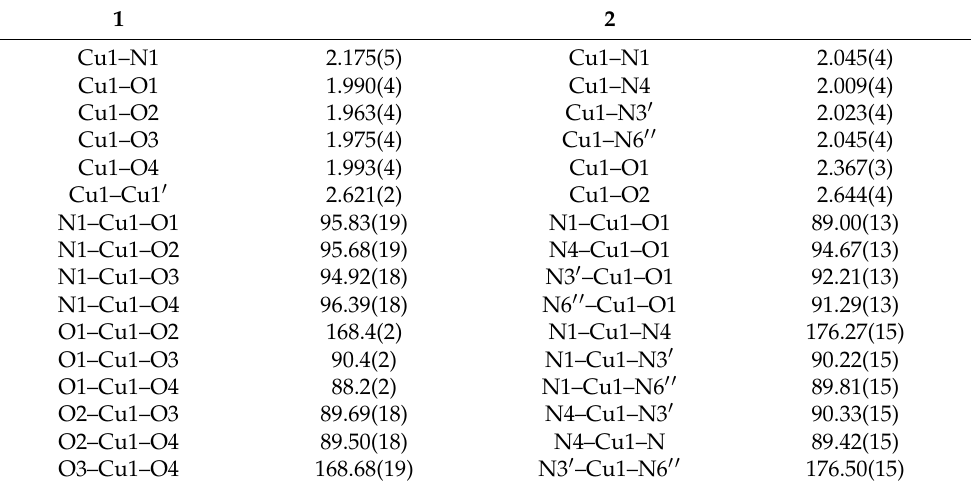
Table 2. Selected bond distances (Å) and angles ( ◦ ) for polymers 1 and 2 .